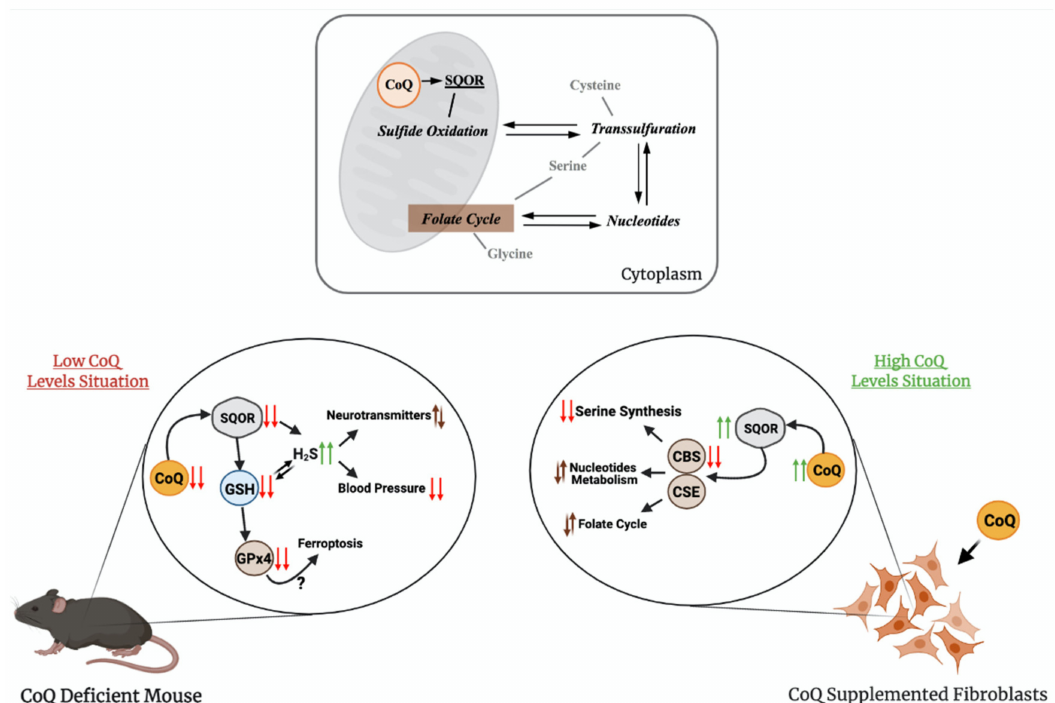
Figure 3. The relation of CoQ with sulfide metabolism and other linked pathways. The upper panel shows how CoQ is connected to sulfide metabolism and one-carbon metabolism. The bottom panel shows the main finding on these pathways in conditions of supraphysiological levels of CoQ 10 or deficiency in CoQ 10 . SQOR = sulfide:quinone oxidoreductase; CBS = cystathionine- β -synthase; CSE = cystathionine γ -lyase; GSH = glutathione; H 2 S = hydrogen sulfide; GPx4 = glutathione peroxidase